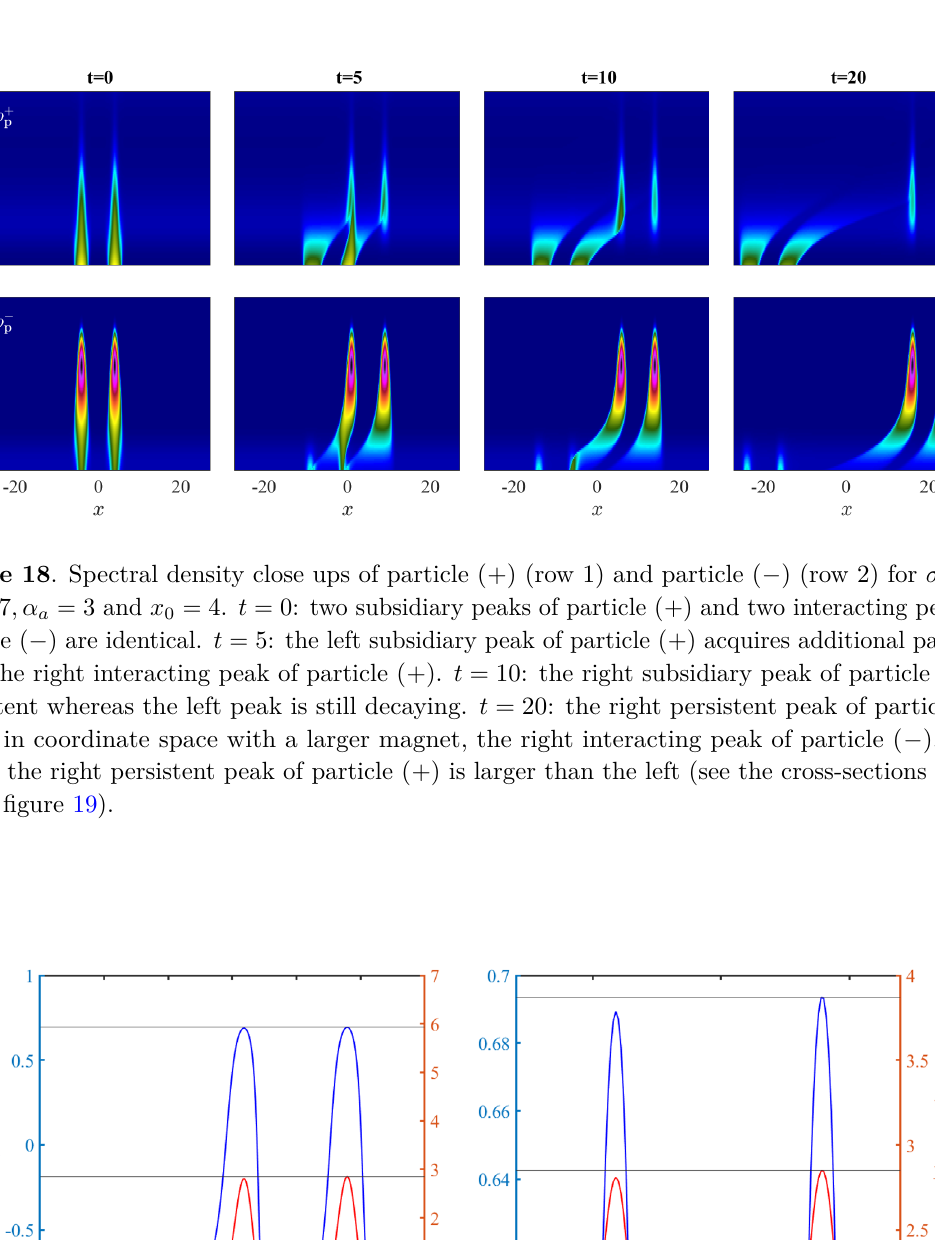
= 7 , α = 3 , σ = 10 and x = 4 m a 0